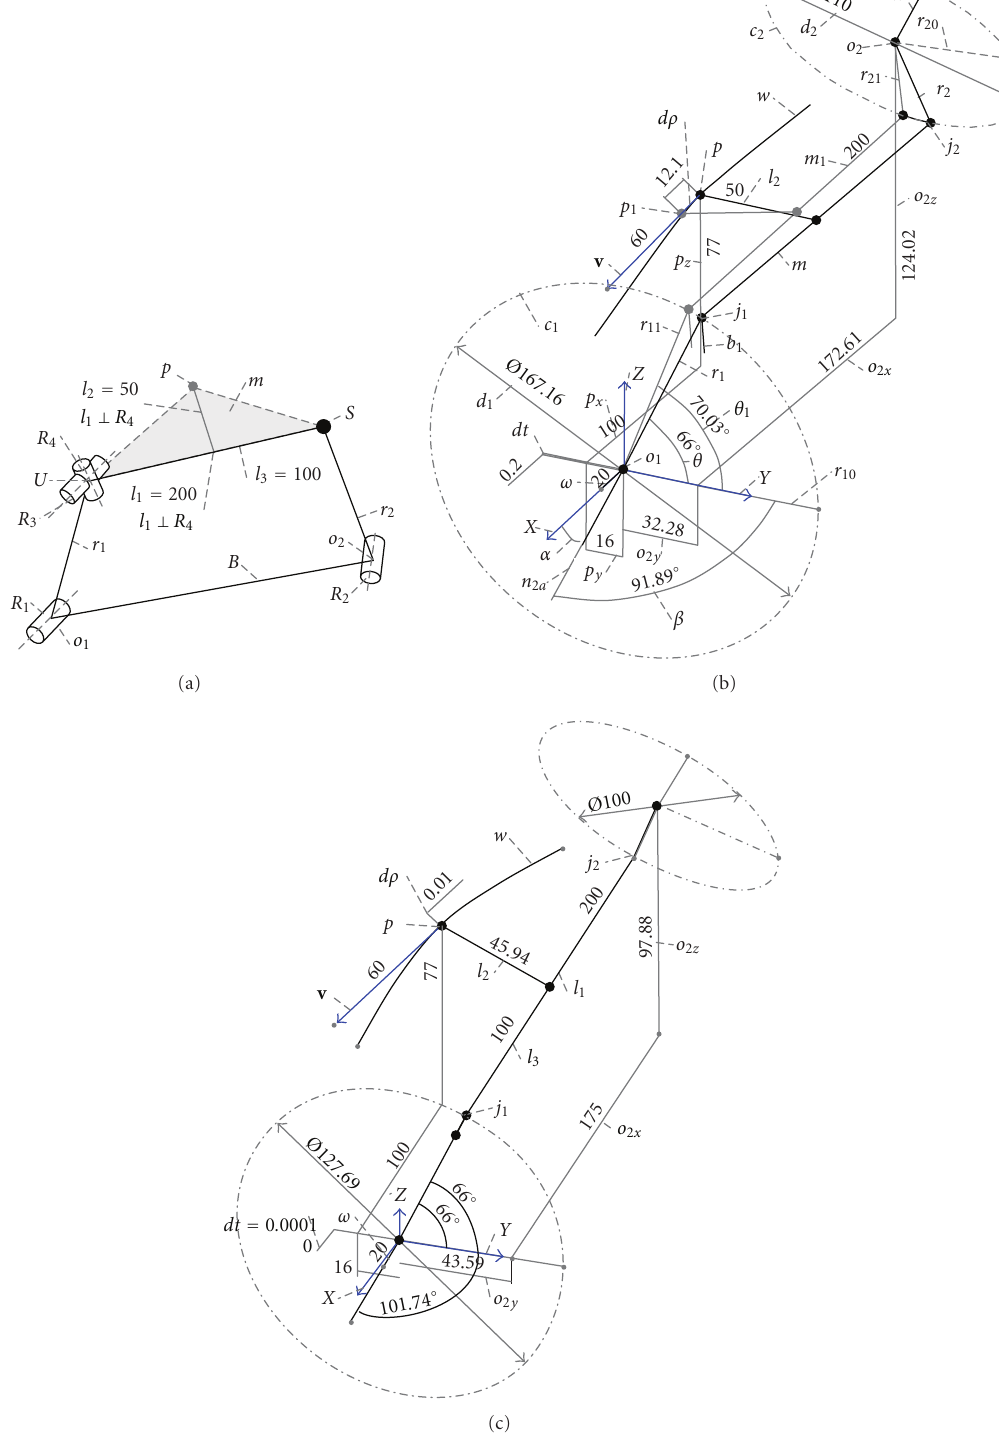
Figure 4: A spatial four-bar mechanism with one-DOF and its velocity simulation mechanism versus d ρ = 12 . 1,0 .